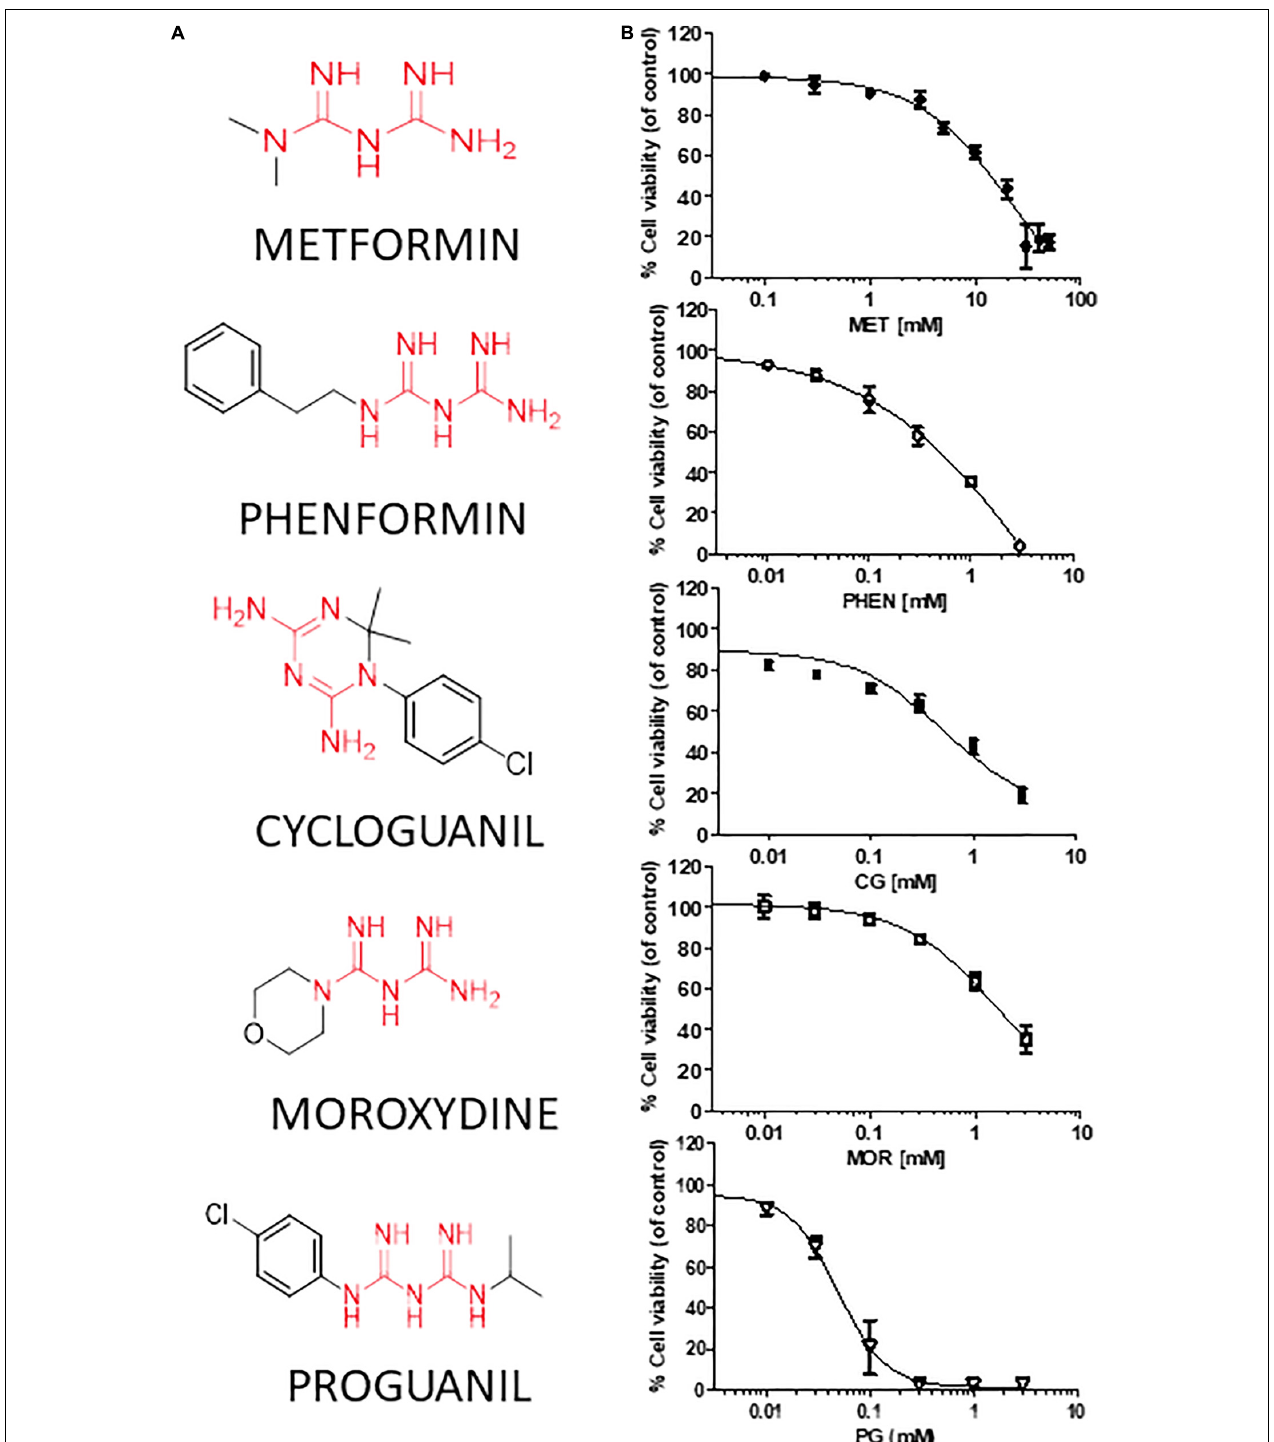
FIGURE 2 | Metformin, phenformin, cycloguanil, moroxydine, and proguanil affect viability of glioblastoma stem cells. (A) Structural formulas of the compounds tested with the biguanide moiety highlighted in red. (B) Dose-response curves of the antiproliferative effect of biguanide derivatives on GBM CSC viability, evaluated by MTT assay after 48 h of treatment. Data were obtained from several GSC cultures, and represent the mean ± SEM of at least n = 3 independent experiments for each GBM, performed in quadruplicate on each culture. Metformin effects were tested in all the 7 GSC cultures, phenformin and cycloguanil in GBM1-6, moroxydine in GBM1-4 and 6, and proguanil in GBM2-4. Effects on individual GBM cultures are reported in Supplementary Figure S1 . ∗ p < 0.05, ∗∗ p < 0.01, ∗∗∗ p < 0.001 vs. CTR (ANOVA, Dunnett’s post hoc test).